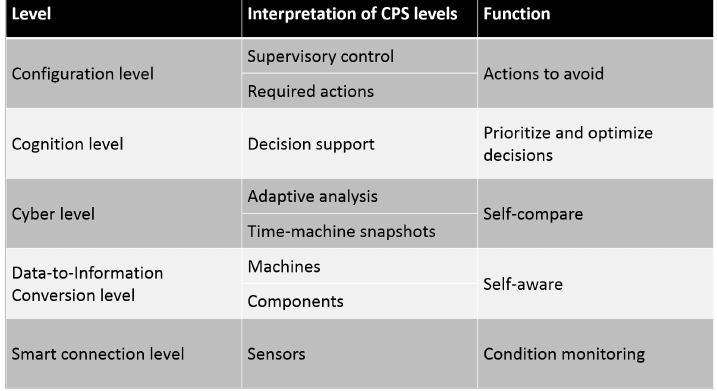
Figure 2. Architecture of cyber-physical systems. Table 3. Levels of cyber-physical systems from the perspective of